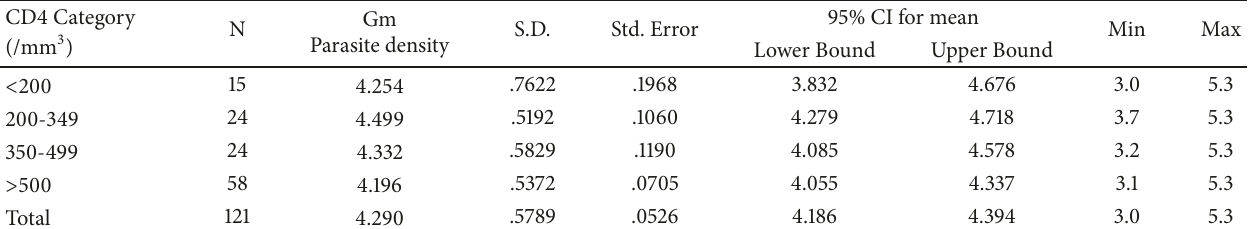
Table 3: Geometric mean parasite density in the four categories of CD4